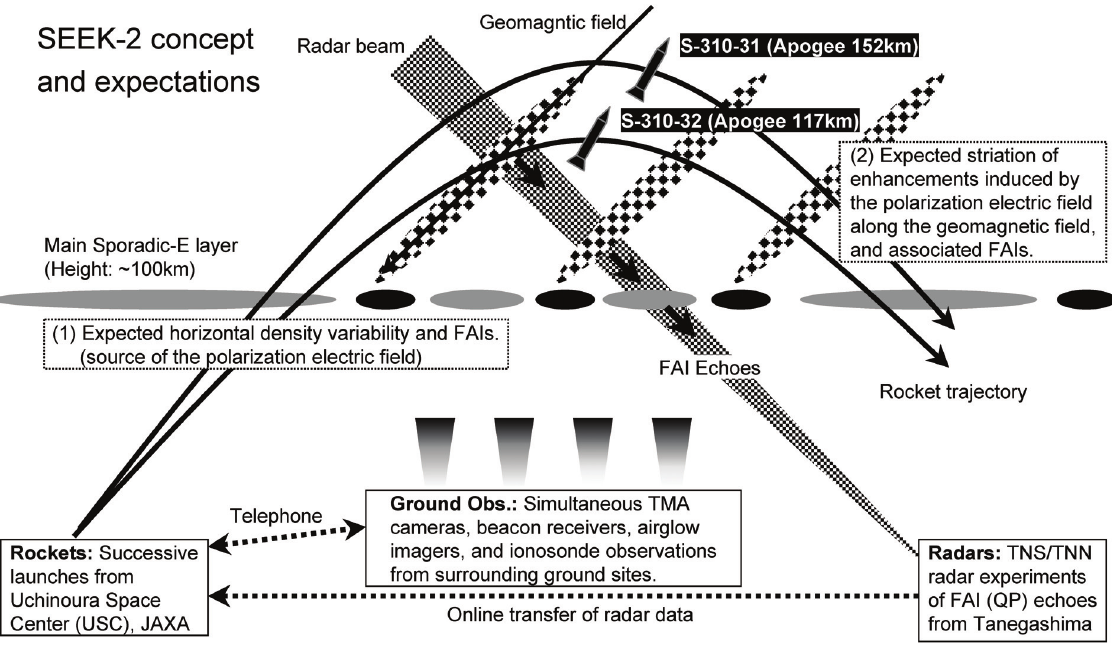
Fig. 1. SEEK-2 experiment. We planned to launch two sounding rockets, S-310-31 and S-310-32, into the region with intense FAI echoes detected by two portable radars in Tanegashima. Horizontal structures of an E s -layer and field-elongated structure of the E-region plasma were expected from several studies before the experiment, which was based on Fig. 9 of Ogawa et al.